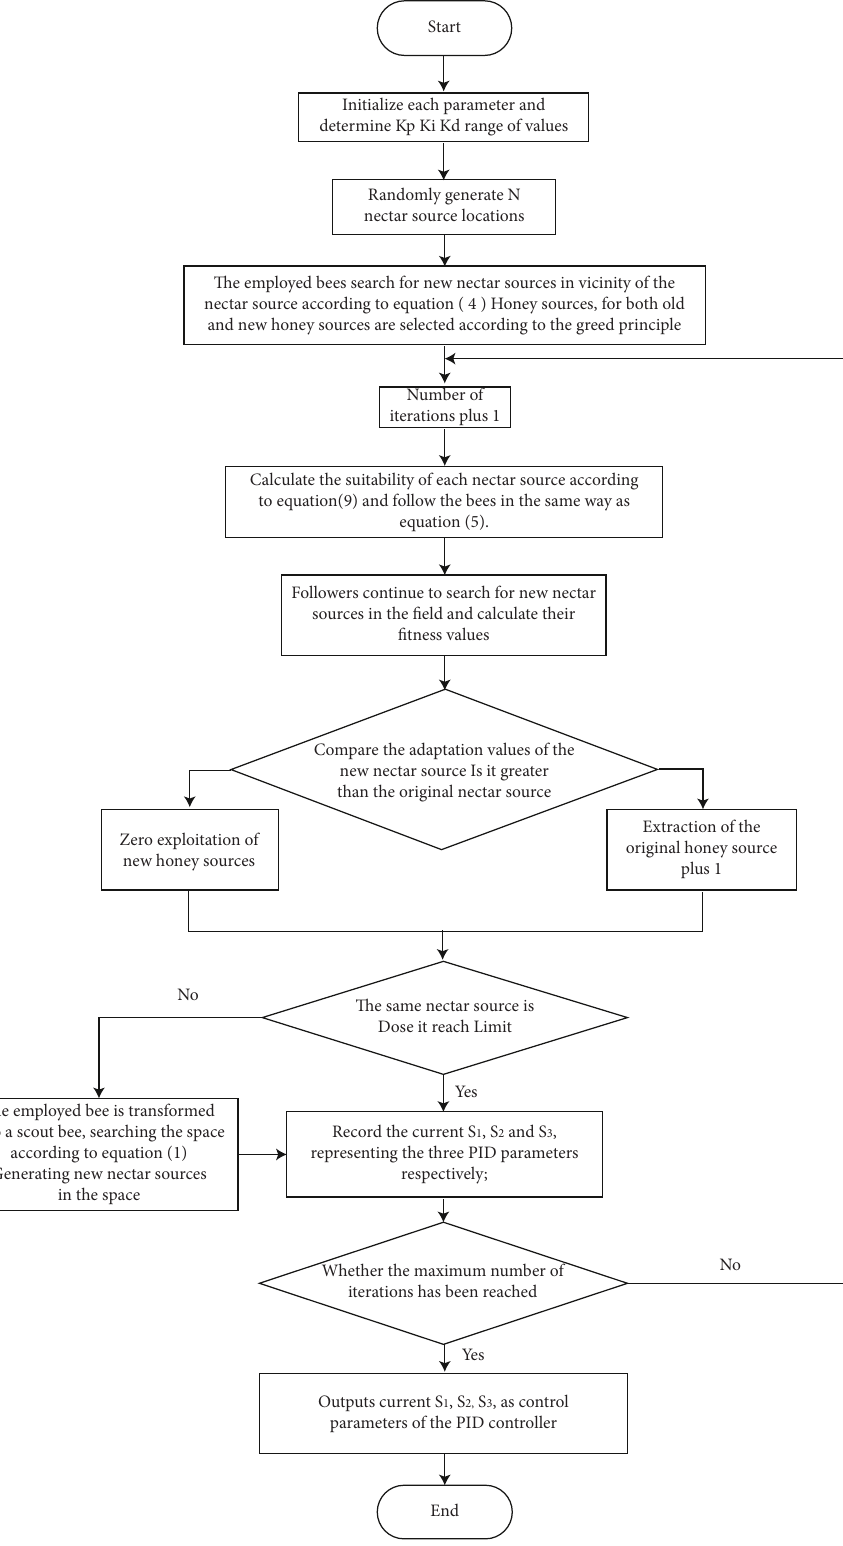
Figure 3: The flowchart of the reformative artificial bee colony algorithm for optimizing PID controller